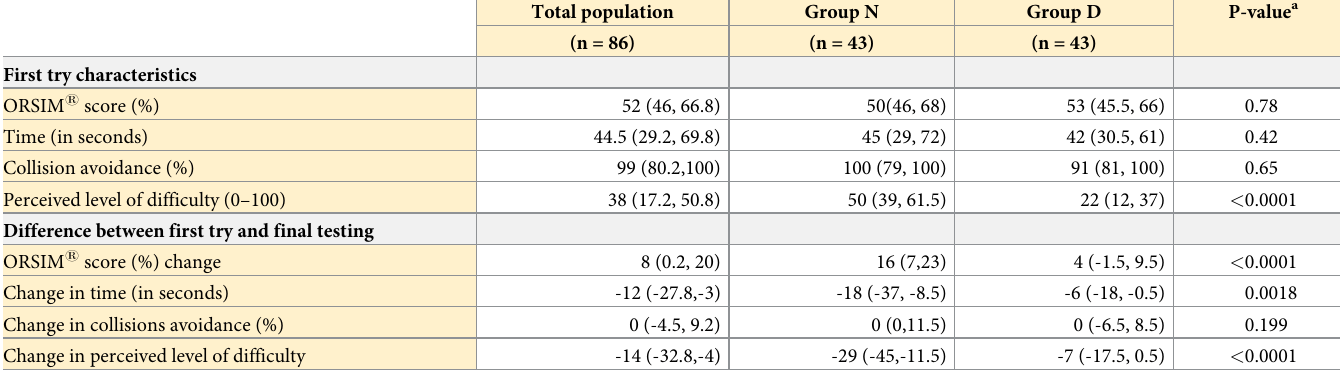
Table 4. Performance evolution on normal airway scenario between first try and final testing according to groups.